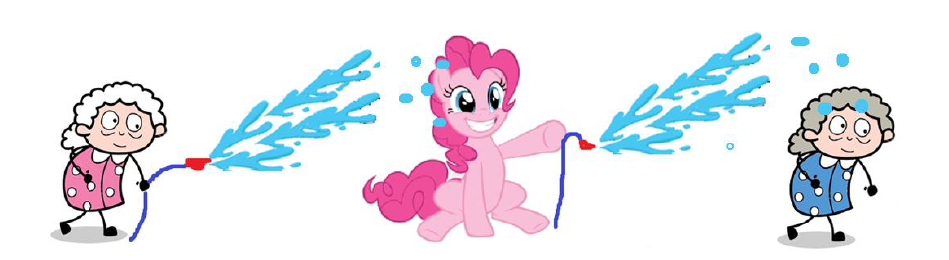
Figure 2. Example of images used to assess comprehension of object relative clauses with a 1 st -person pronoun